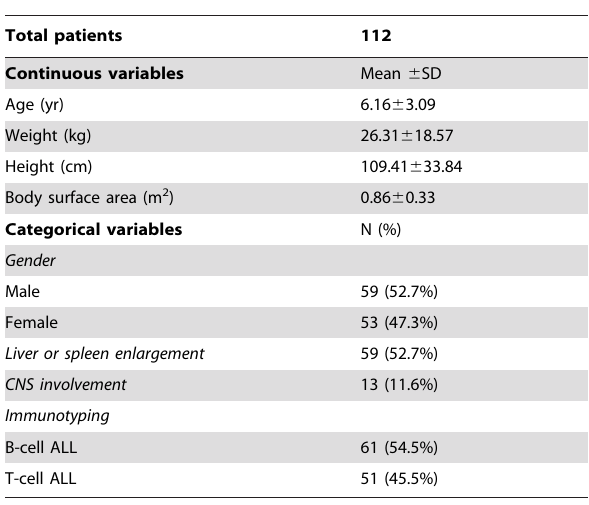
Table 1. Characteristics of patients.